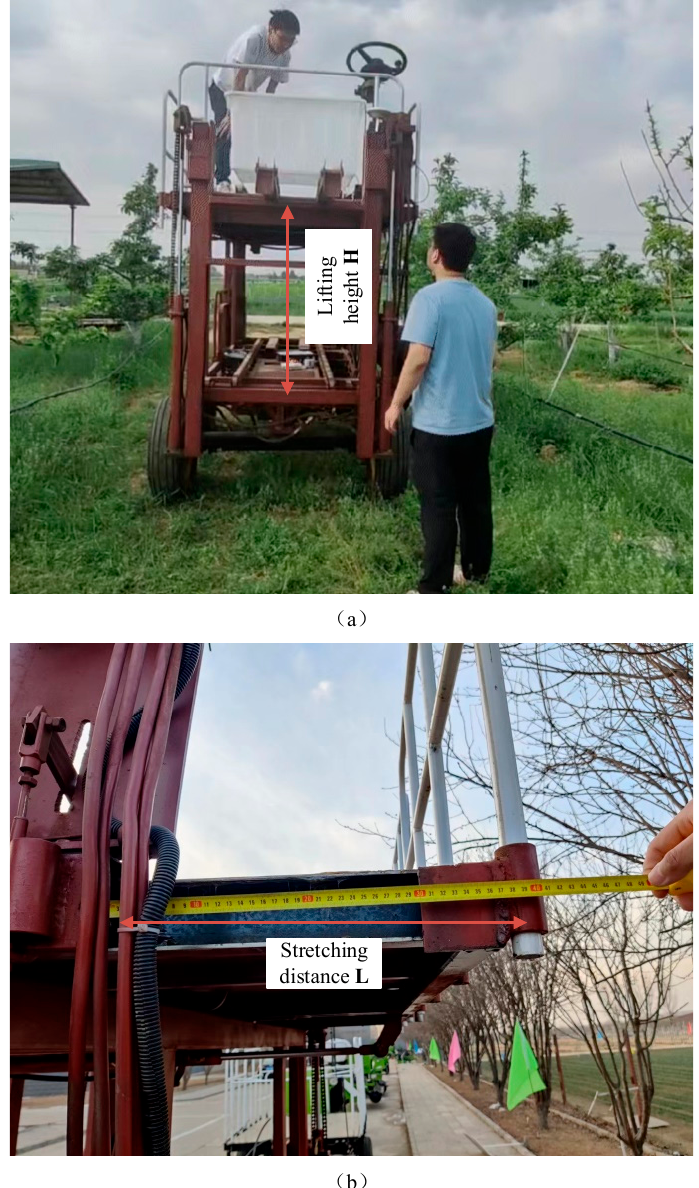
Figure 21. Voice control experiments. ( a ) Lifting test for the fruit-box-lifting device. ( b ) Extension test for the the high-level extendable working platform. Table 13. Pedal extension length.